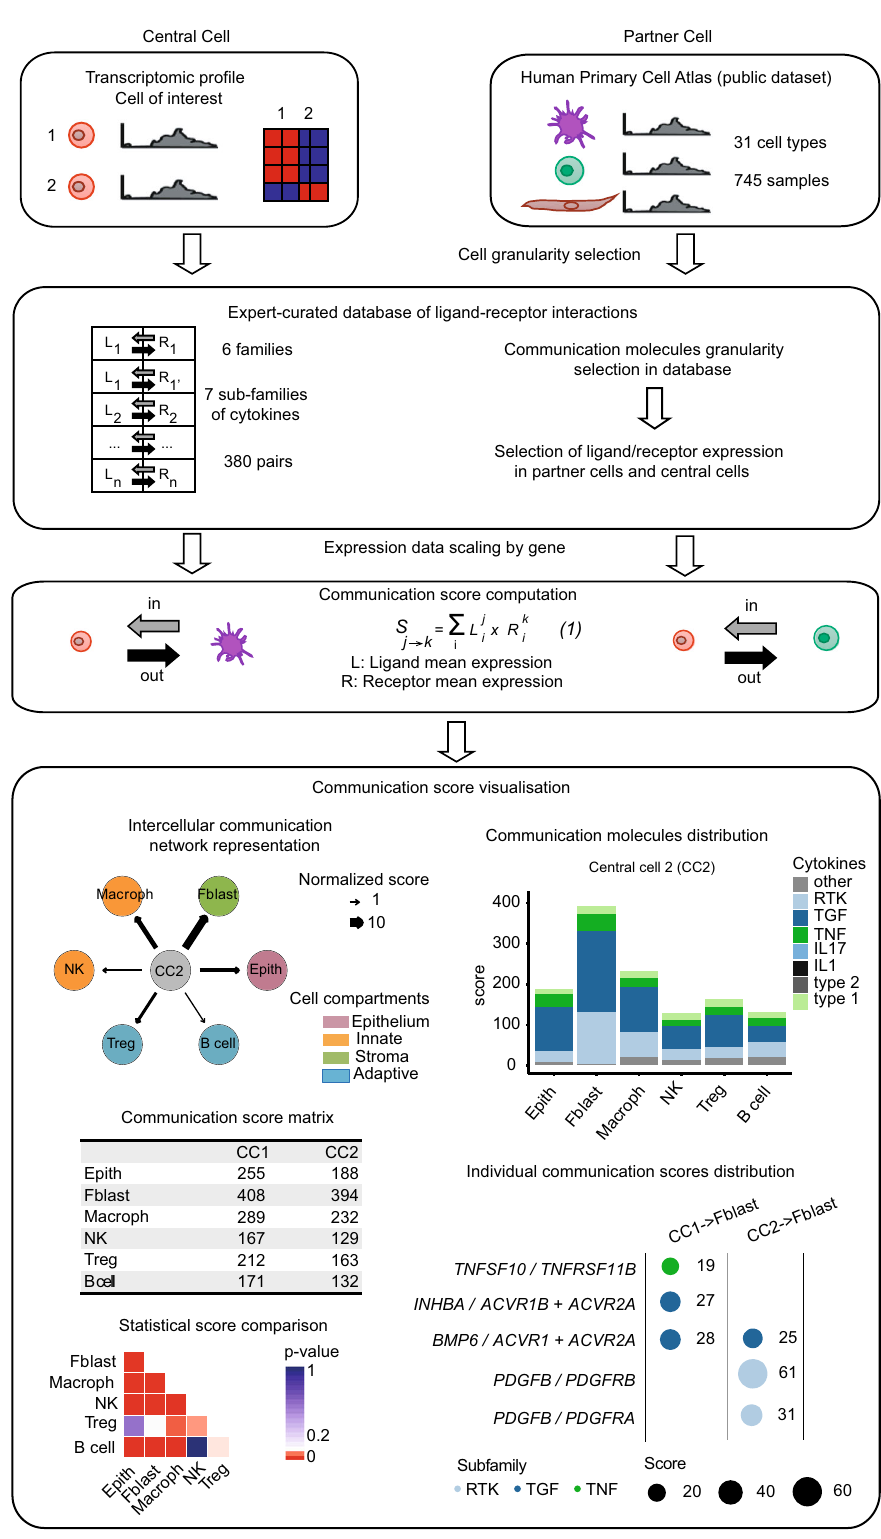
in directed connectivity maps. In these graphs, nodes represent cell types, the width of the edges connecting two cell types is proportional to their global communication score and the arrows indicate the direction of communication. The second visualiza- tion mode breaks down the global scores into the contribution of speci fi c molecular families through a barplot representation. This allows the identi fi cation of patterns of co-expressed molecules